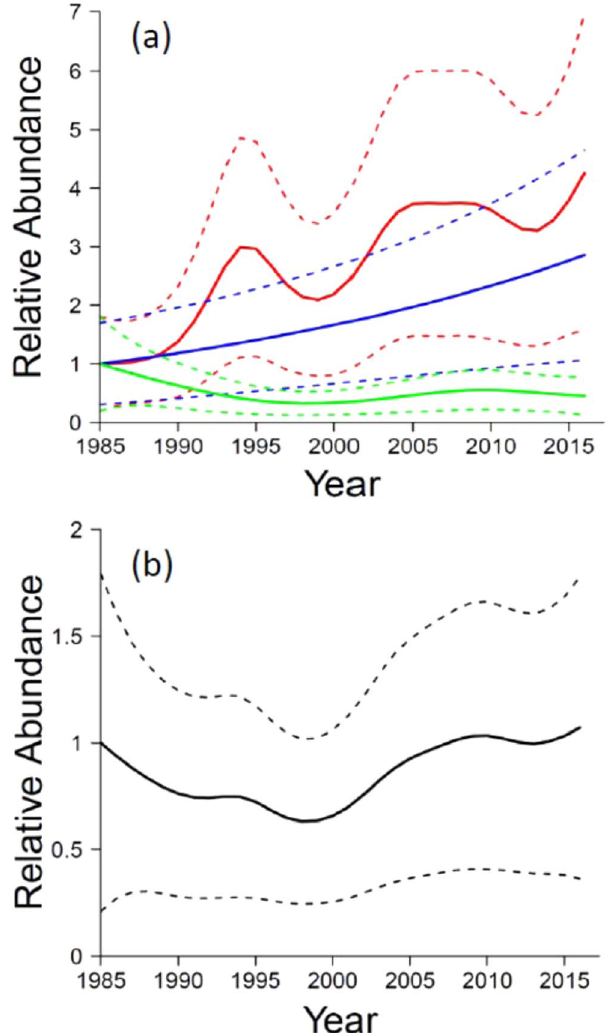
Figure 1. Relative abundances (solid lines) ± 95% CI s (dotted lines) of hibernating Townsend’s big-eared bats by year ( a ) across three study areas and ( b ) overall. Trajectories are from the best model, based on 244 surveys in 39 caves in southern Idaho, USA, from winter 1984–1985 (labeled as 1985 in the figure) to winter 2015–2016. In panel a, Big Desert = red line, Sand Creek Desert = blue line, and Shoshone Desert = green